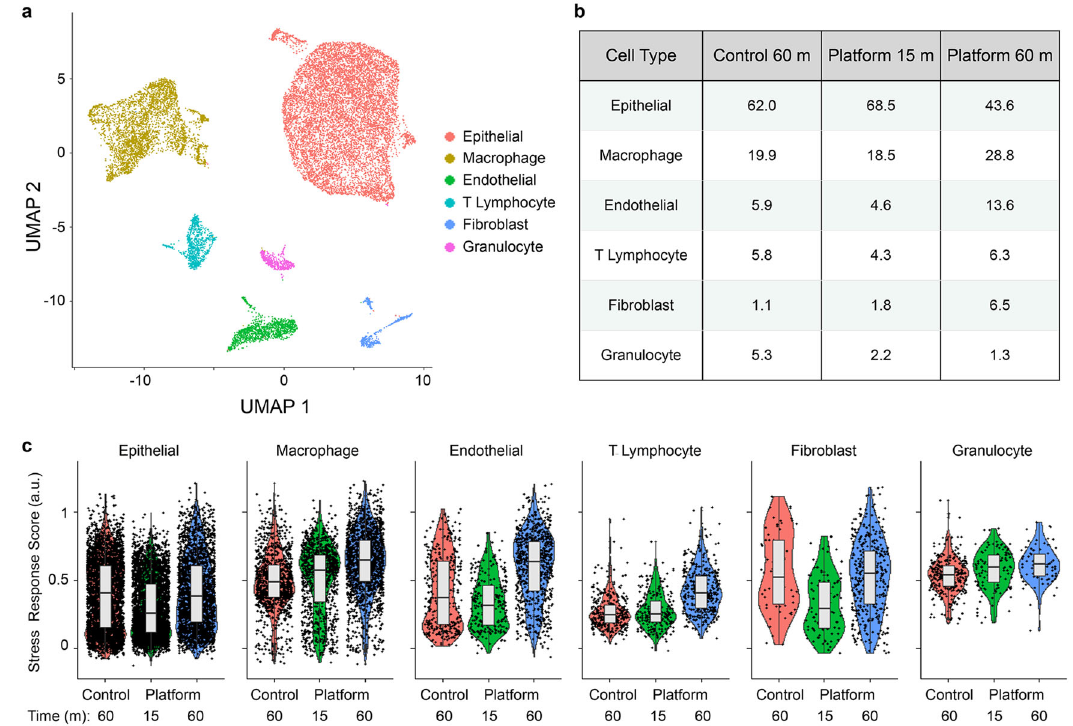
Fig. 6 scRNA-seq of murine mammary tumor ( n = 1). Cell suspensions obtained from the micro fl uidic platform at 15 and 60 min intervals, as well as the 60 min control, were processed and analyzed using similar methods to kidney. a UMAP displaying six cell clusters that correspond to epithelial cells, macrophages, endothelial cells, T lymphocytes, fi broblasts, and granulocytes. b Population distributions for each cell cluster and processing condition. Epithelial cells were predominantly eluted from the micro fl uidic platform in the 15 min interval, while endothelial cells and fi broblasts were enriched in the 60 min interval. Fibroblasts were enriched in both platform conditions, while granulocytes were depleted. c Stress response scores, displayed in violin plots, were generally similar across conditions and cell types. Horizontal line depicts median and edges of box depict 1 st and 3 rd Table S5). Differences for the device aggregate relative to the control were ~2-fold for epithelial cells and 2.5- to 3-fold for T lymphocytes and macrophages, which are all similar to fl ow cytometry results (Fig. 5a, c). Endothelial cells were ~4-fold greater for the device platform, which is lower than the 10-fold difference from fl ow symmetry (Fig. 5b). Notably, fi broblasts were enriched by 10-fold using the device platform. Our results con- fi rm that tissue processing with the micro fl uidic device platform can improve isolation of all cell types by at least 2.5-fold, as well as dif fi cult to liberate cell types such as endothelial cells, fi bro- blasts, and basal epithelium by 4- to 10-fold.